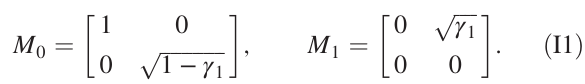
Fig. 15 considers the same Heisenberg evolution treated in Fig. 8 and described in Sec. IV B. In both cases, we show the error in the unmitigated noisy state, the states accessed by virtual distillation with M ¼ 2 and M ¼ 3 copies, and the dominant eigenvector of the noisy density matrix. We quantify the error in terms of the trace distance to the ideal state that would be obtained in the absence of noise, plotting this trace distance as a function of the expected number of errors.